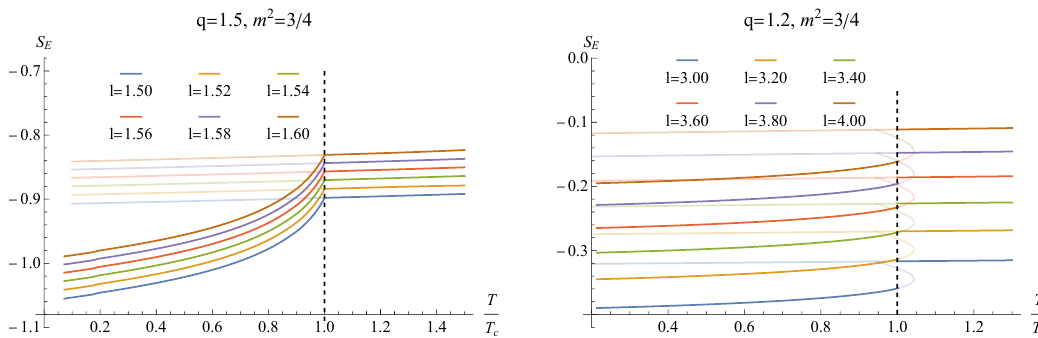
Figure 7 . The holographic entanglement entropy S E vs temperature T/T c with various strip width l . The critical point is indicated by the black dashed line. The stable and metastable states are depicted by solid and transparent lines, respectively. Left plot: the second-order phase transition at T c ≈ 0 . 01791 . Right plot: the first-order phase transition at T c ≈ 0 . 003382 . The entropy density is given